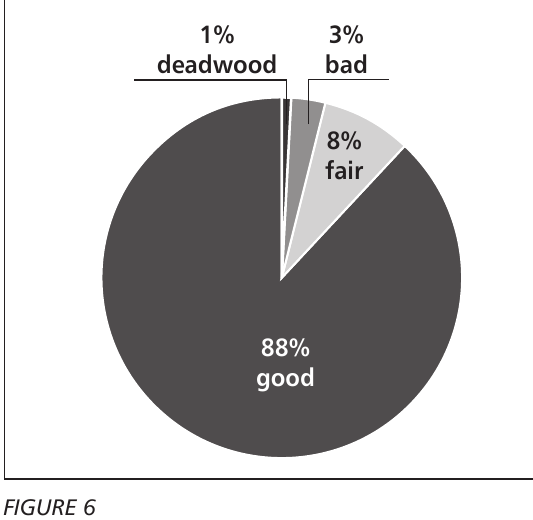
Distribution of woody plants by condition Trees showing the most damage are street trees. The most common injuries are found on tree stems and roots. Aesculus hipocastanum L . leaves were massively damaged by Cameraria ohridella